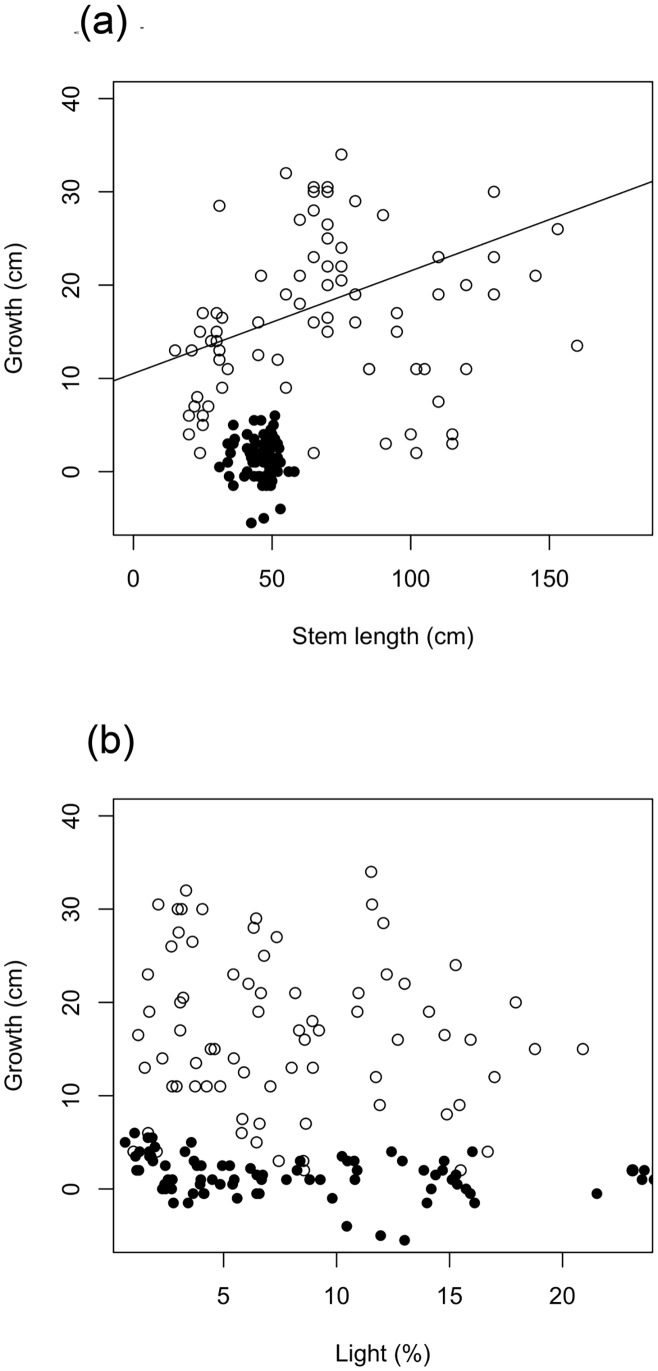
Stem growth as a function of stem length at t0 and total light.Commercial plant data are black points. Gardens plant data are white points and solid line. Line represents model estimates (fixed effects) for growth as a function of stem length at t0.